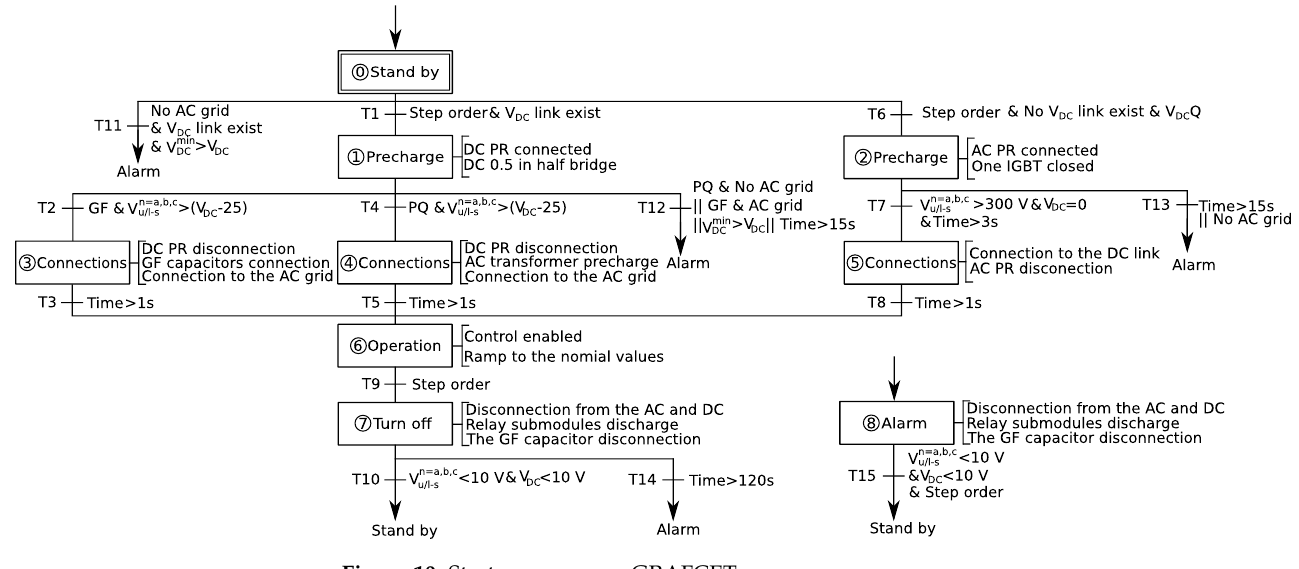
Figure 10. Start-up sequence